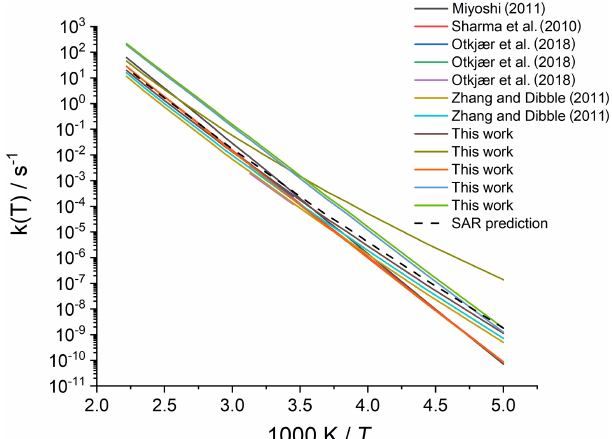
Figure 2. Rate coefficient for 1,5-H migration in an aliphatic alkyl (cid:113) peroxy radical with a > CH(OO ) radical group and a secondary (–CH 2 –) migrating H atom. The literature data for the various re- actions in this class are scattered over a factor of 22; the final SAR predictions are within a factor of 7 of all data at 298K and incorpo- rate the average temperature dependence of the five predictions that explicitly treat tunnelling corrections below